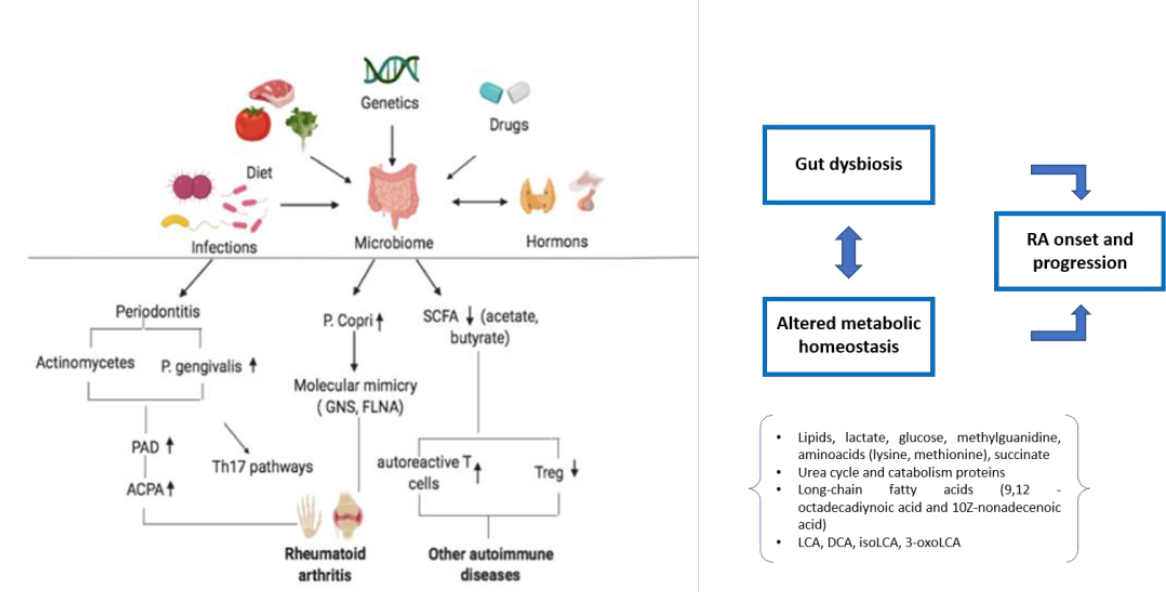
Figure 1. Dysbiosis and altered metabolic homeostasis in rheumatoid arthritis. Genetics, infections, and other environmental factors are involved in dysbiosis, triggering the immunological mecha- nisms underlying RA development. Gut dysbiosis and altered metabolic pathways contribute to RA onset and progression. RA: rheumatoid arthritis; PAD: peptidyl-arginine deiminases; ACPA: anti- citrullinated protein antibodies; SCFA: short-chain fatty acids; LCA: lithocholic acid; DCA: deoxy- cholic acid; isoLCA: isolithocholic acid; 3-oxoLCA: 3-oxolithocholic acid.